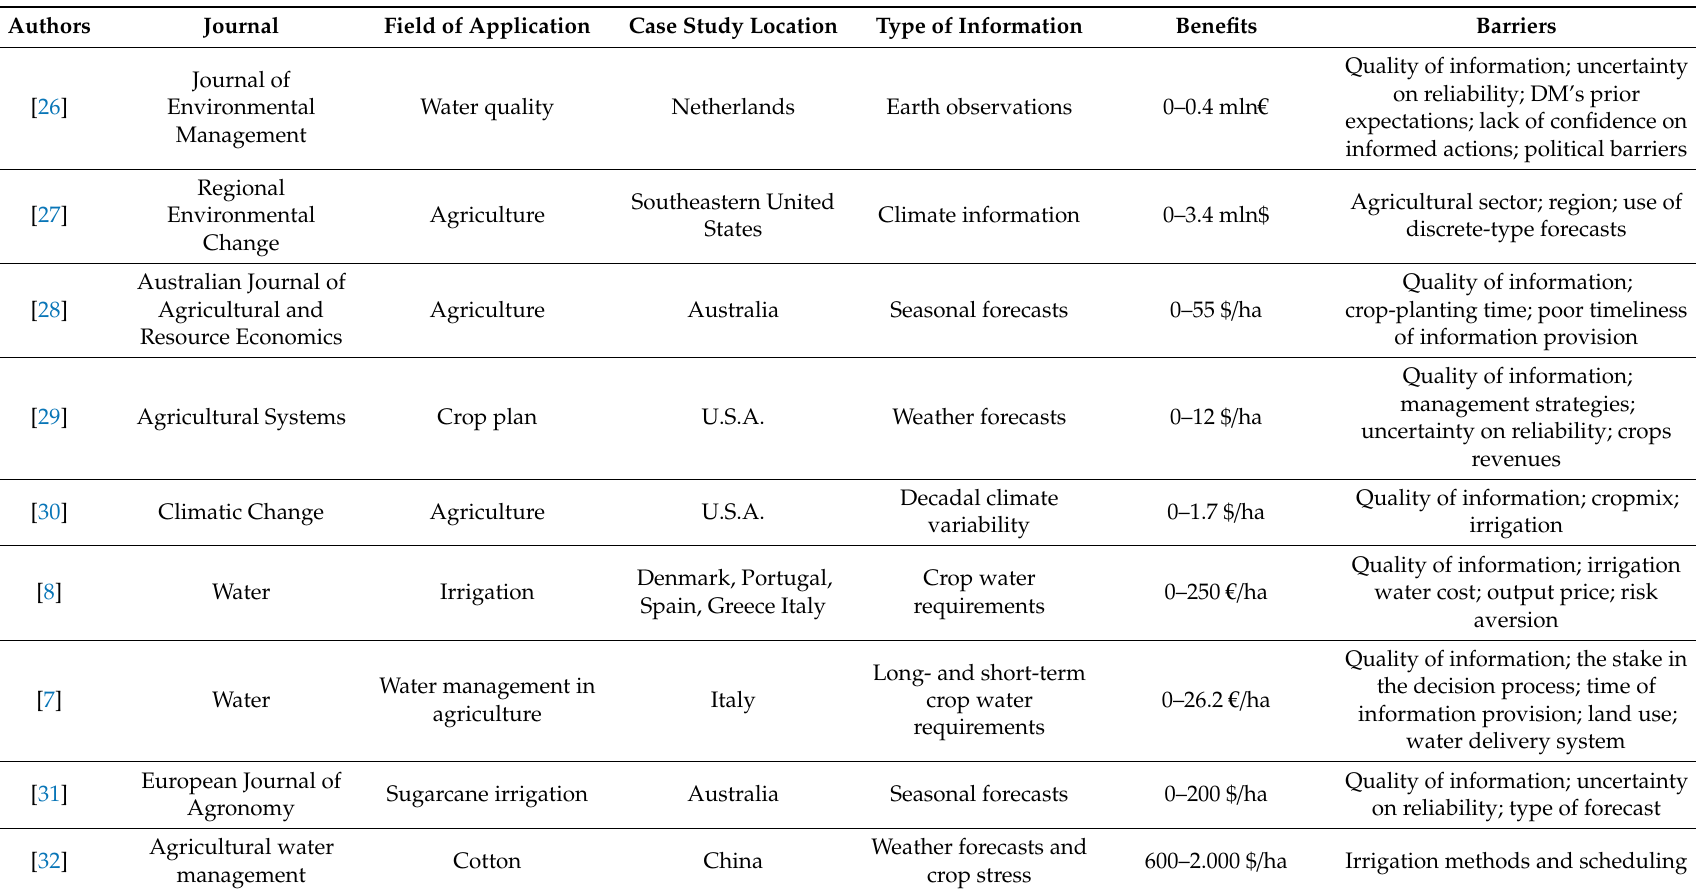
Table 1. Examples of estimation of benefits from information